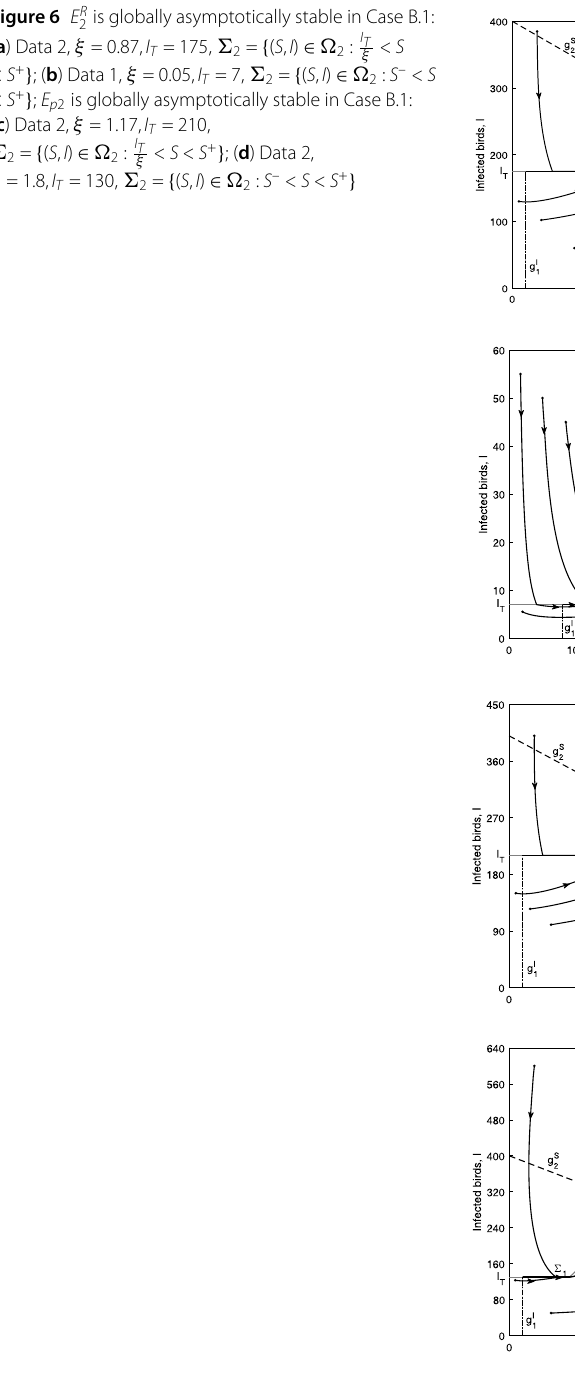
Figure 6 E R 2 is globally asymptotically stable in Case